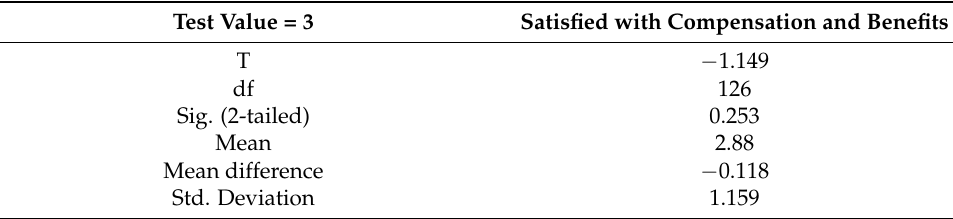
Table 7. Employees are considerably satisfied with their compensation and benefits package.